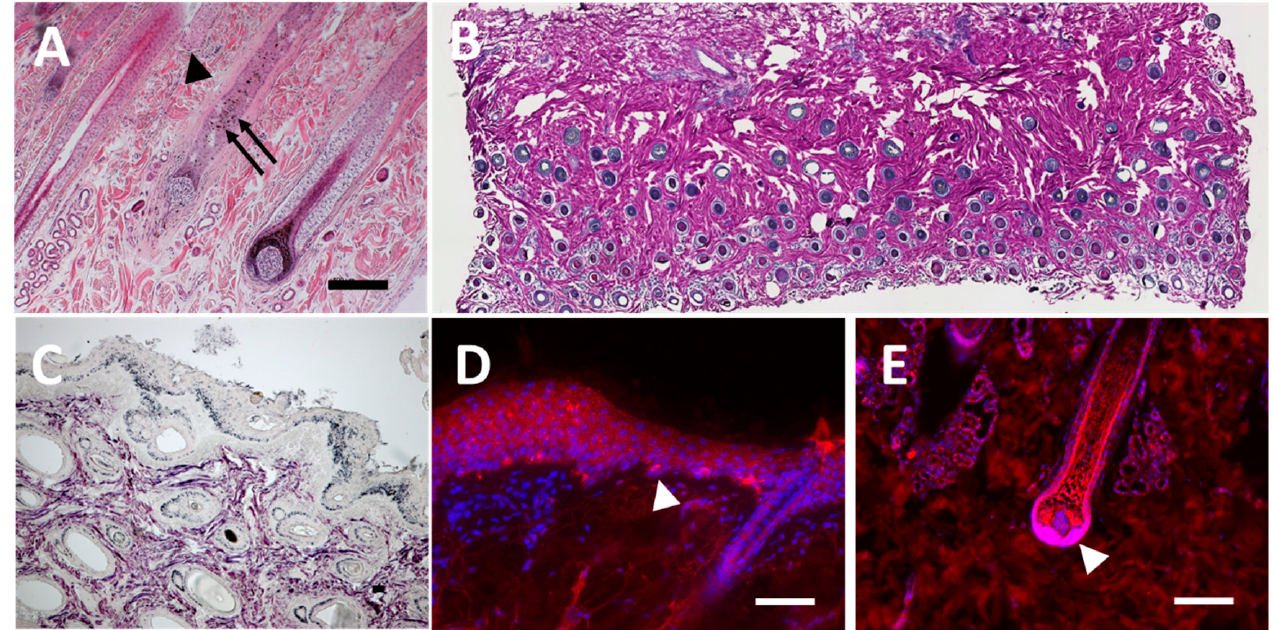
Figure 1. H&E, Fontana Masson stain and tyrosinase immunofluorescent labeling of horse forehead skin. ( A ) Histological cross-section of the equine forehead skin was stained with H&E for morphological analysis. The hair follicles’ base is surrounded by sweat glands (arrowhead, A ). Outer root sheath (ORS) melanocytes showing melanin deposits are marked with arrows (arrows, A ). ( B ) Perpendicular section of horse forehead skin with observable hair follicles. ( C ) Fontana Masson-staining of metallic silver deposit in melanocytes in both hair follicle ORS and the basal layer of the epidermis. ( D , E ) Immunostaining of tyrosinase in horse forehead skin specimen displayed positive staining of functional melanocytes in the basal layer of the epidermis (arrowhead, D ) as well as that of the proximal bulb and matrix region (arrowhead, E ). Scale bar 100 µm. ( A , D , E ) 40× magnification; ( C ) 4× magnification; ( B ): composite image at 4× magnification.